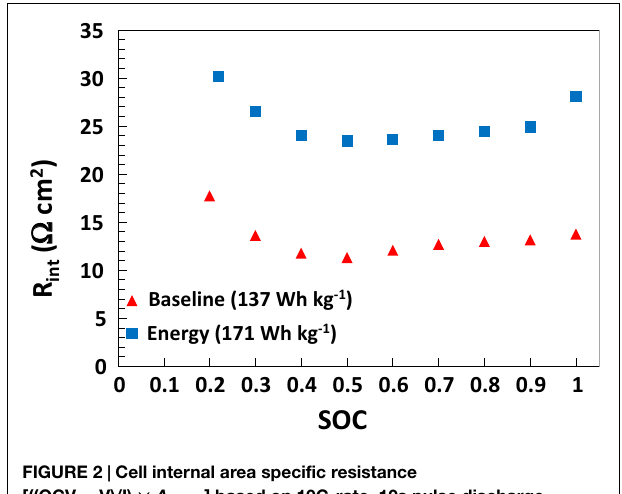
FIGURE 2 | Cell internal area specific resistance [((OCV (cid:0) V)/I) (cid:2) A active ] based on 10C-rate, 10s pulse discharge current versus cell SOC at 25°C, as predicted by AutoLion™ (using the AutoLion™ database) for both baseline and energy 5Ah medium cells .